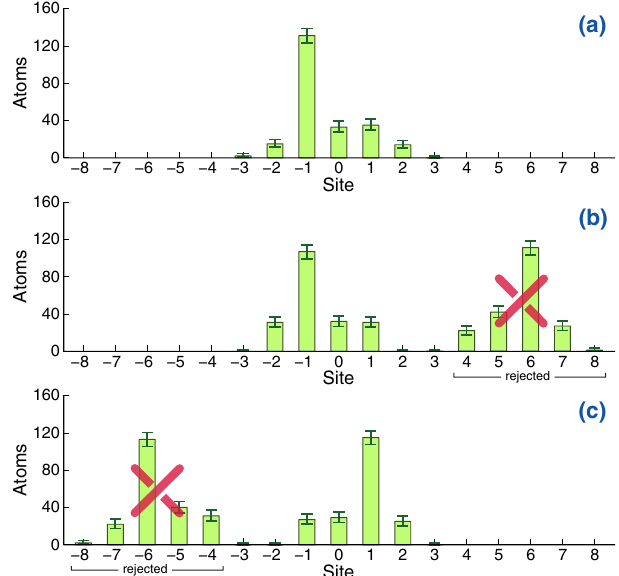
FIG. 3. Violation of Leggett-Garg inequality probing a four- step quantum walk. The spatial distribution of single atoms is reconstructed by measuring their positions at time t 3 : (a) If we do not observe which trajectory the atom has taken at t 2 , the distribution exhibits a pronounced peak on the left-hand side. However, when we conclude from an ideal negative result whether the atom at time t 2 was in (b) x ¼ − 1 or (c) x ¼ 1 , we obtain two distributions that resemble the mirror image of one other. The events in which the atom ’ s position has been affected by Q ð t 2 Þ measurement are recognized through the larger dis- placement and, thus, rejected. Because the overall number of probed atoms, 404, is the same in (b) and (c), the retained events can be added together to produce the position distribution at t 3 conditioned on having measured the position at t 2 . The sum distribution (not shown) is symmetric and differs strongly from the asymmetric distribution in (a). The vertical error bars represent 68% Clopper-Pearson confidence intervals.